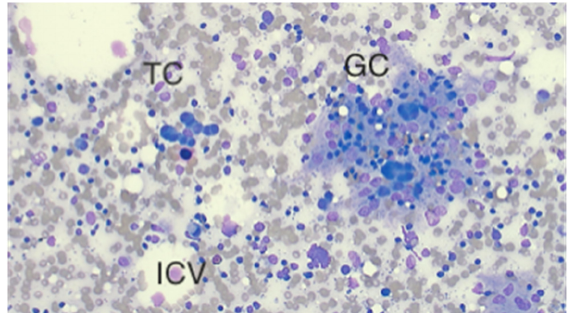
Figure 7. Example of germinal centre tissue fragment (GC, larger tissue fragment at right) with subtle runs of tumour cells (TC) from a metastatic lobular carcinoma at left, in addition to a single cell containing an intracytoplasmic vacuole (ICV). DQ ×200.